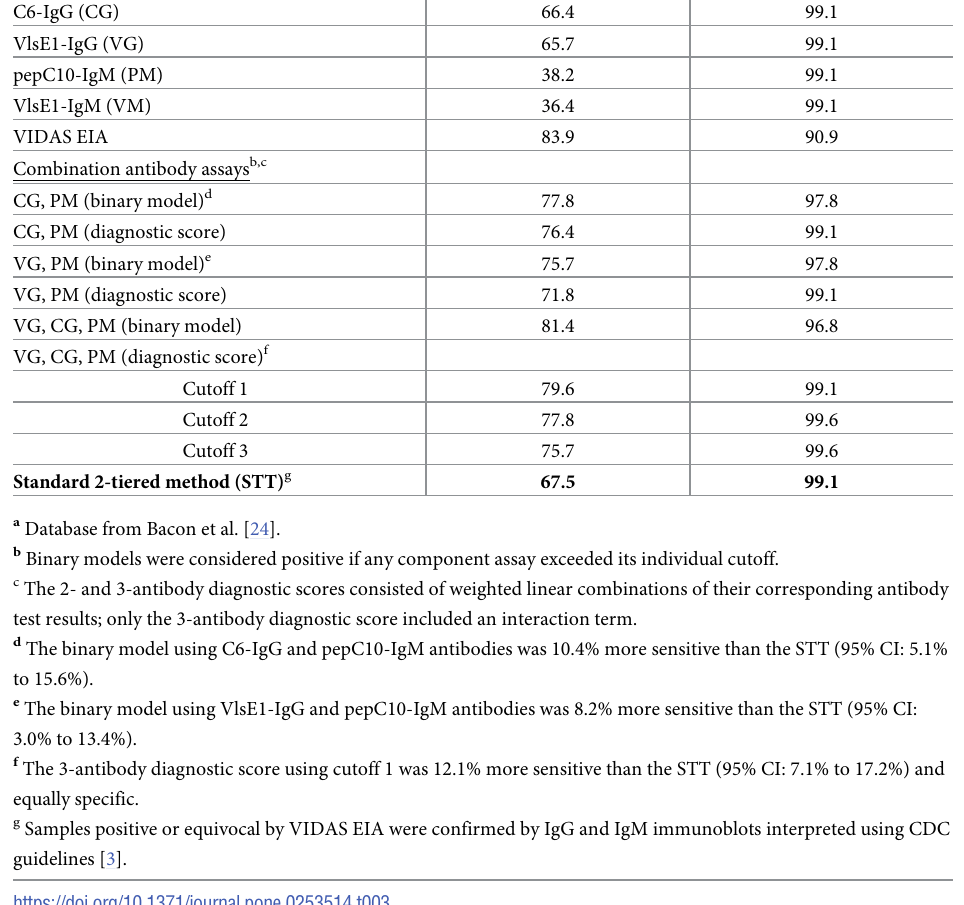
Table 5 provides disease stage-specific comparisons of STT performance versus select binary models, and the 3-antibody diagnostic score. The 3-antibody diagnostic score using cutoff 1 was 22.5% more sensitive than the STT for early-acute-phase disease (95% CI: 11.8% to 32.2%), 16.0% more sensitive for early-convalescent-phase disease (95% CI:7.2% to 24.7%) and was equally sensitive for disseminated infection (92.6% versus 93.6%, respectively); assay specificity was identical (99.1%). The sensitivity of the 3-antibody DS using cutoff 1 was statis- tically equivalent to the 2- and 3-antibody binary models in Table 5 for both early LD and dis- seminated infection, but was 1.3% to 2.3% more specific. Unless a new assay is at least as specific as the STT, confirmatory testing of positive or equivocal first-tier results is recom-